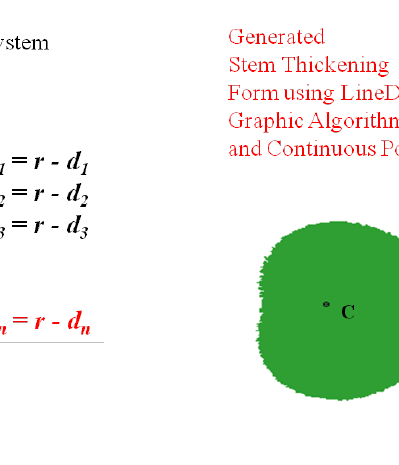
Figure 20. Generation of thickening form of the target plant